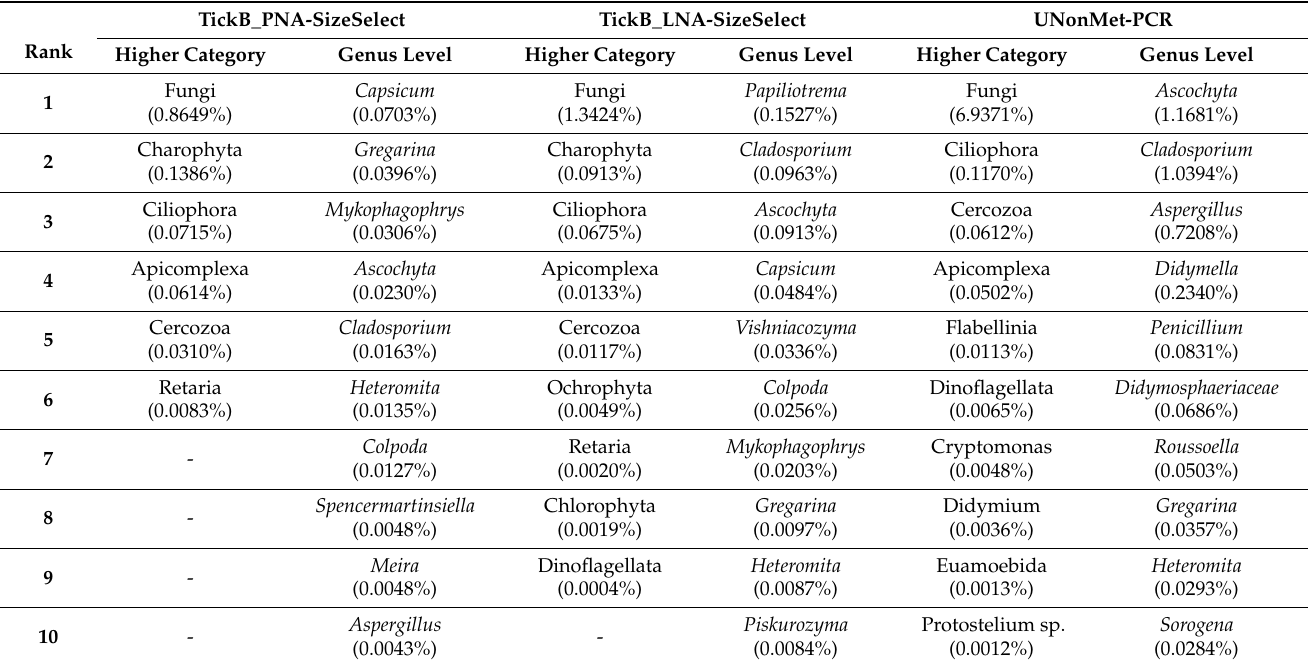
Table 3. Top 10 observed taxa based on the TickB_PNA, TickB_LNA, or UnonMet-PCR methods at a higher taxonomic level and the genus level.